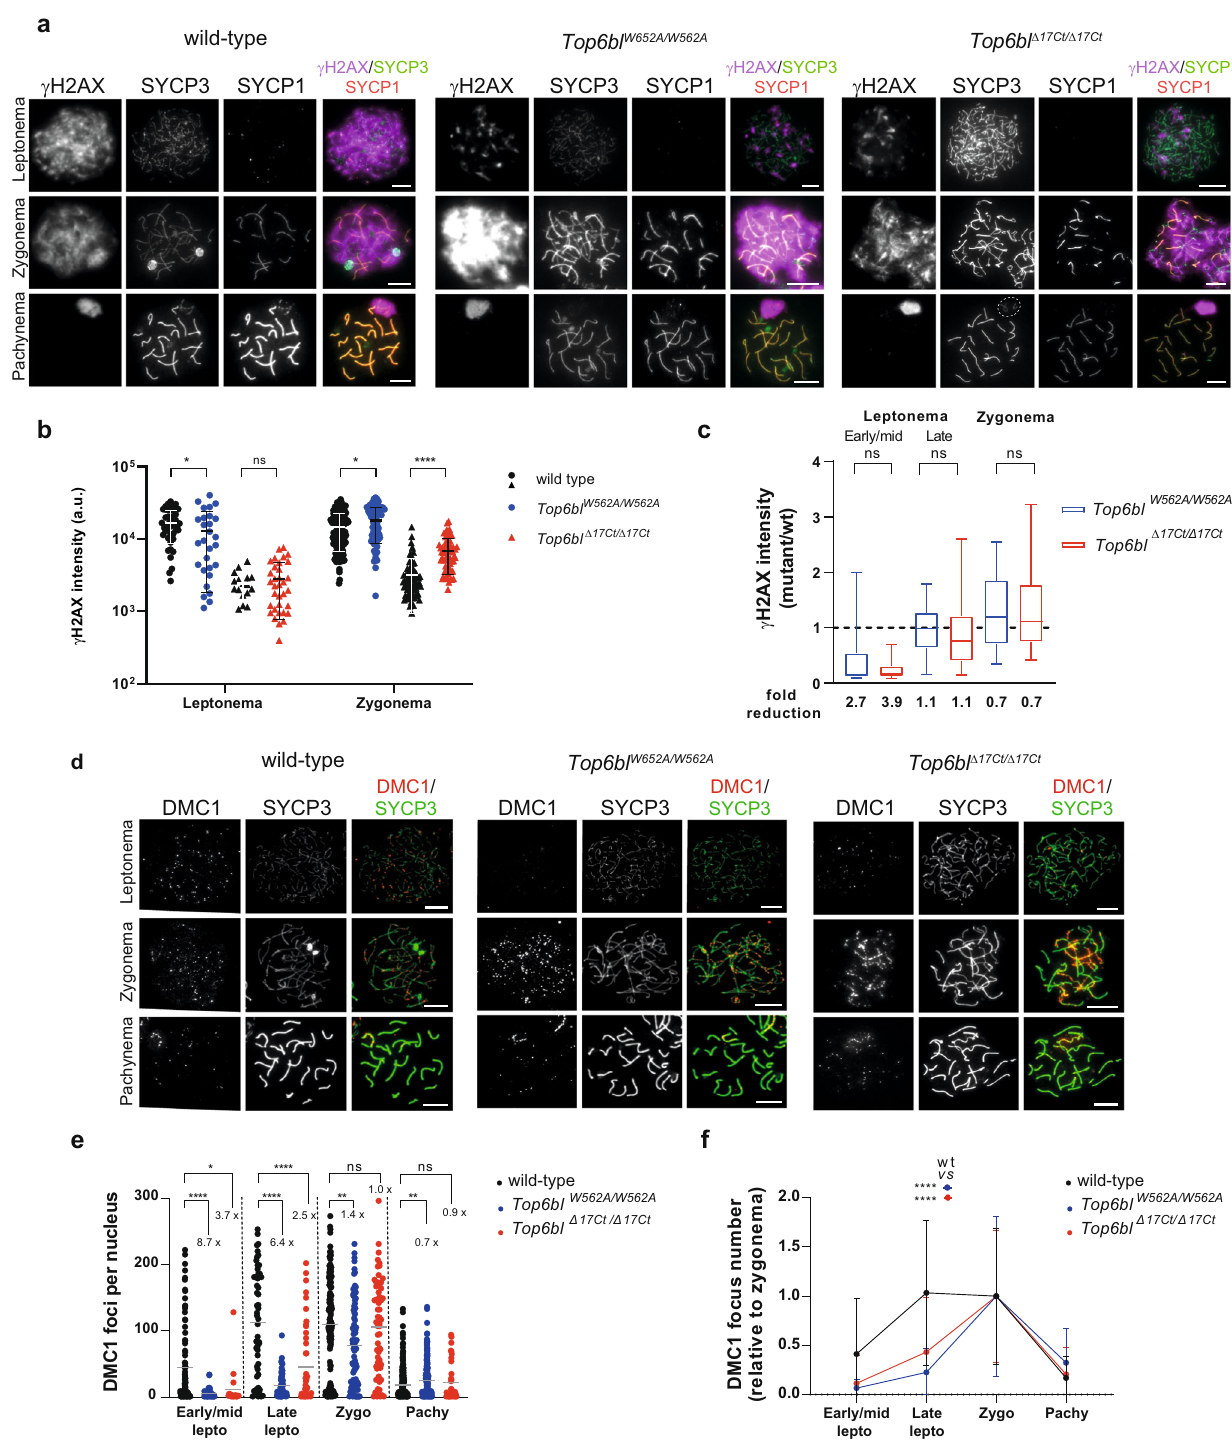
Top6bl (cid:3) 17Ct/ (cid:3)